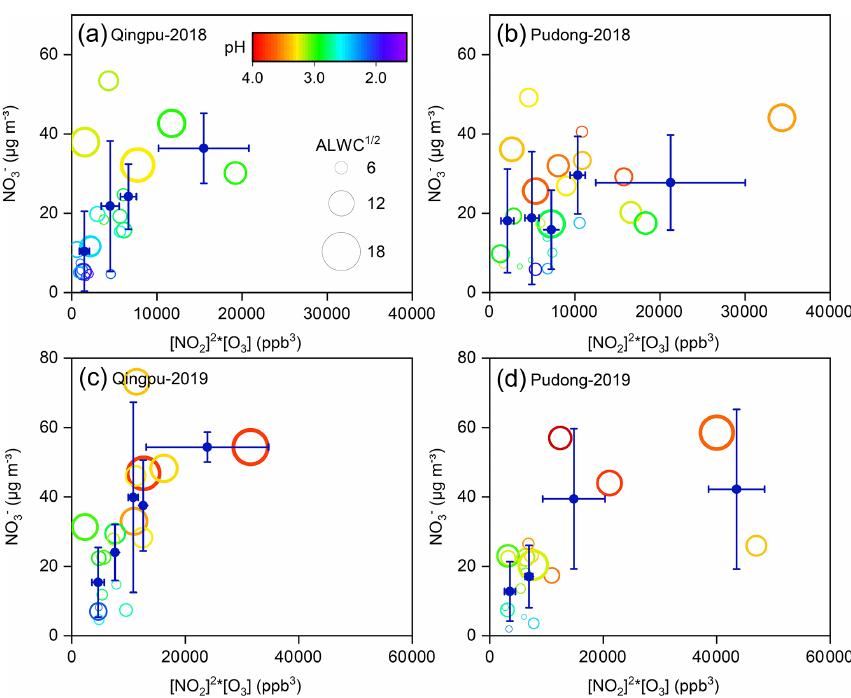
Figure 6. Nighttime average particulate nitrate concentration (empty circles) as a function of [NO 2 ] 2 × [O 3 ] at (a, c) Qingpu and (b, d) Pudong sites in 2018 and 2019. The circles are colored according to aerosol pH, and their size is linearly scaled with the square root of ALWC. The blue filled circles represent the average of nitrate concentration within a certain [NO 2 ] 2 × [O 3 ] interval. To reduce the influences of the daytime remainder on the analysis of nighttime nitrate formation, only the data with an obvious peak or increasing trend during nighttime were included in the